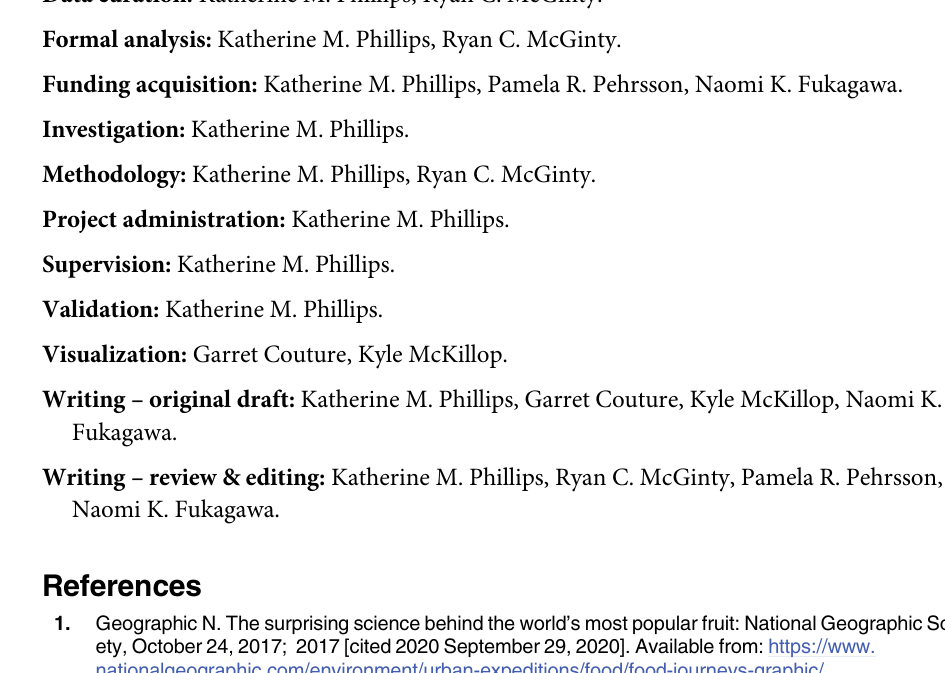
S1 Table. Data for individual samples. Results for analyzed components in individual banana